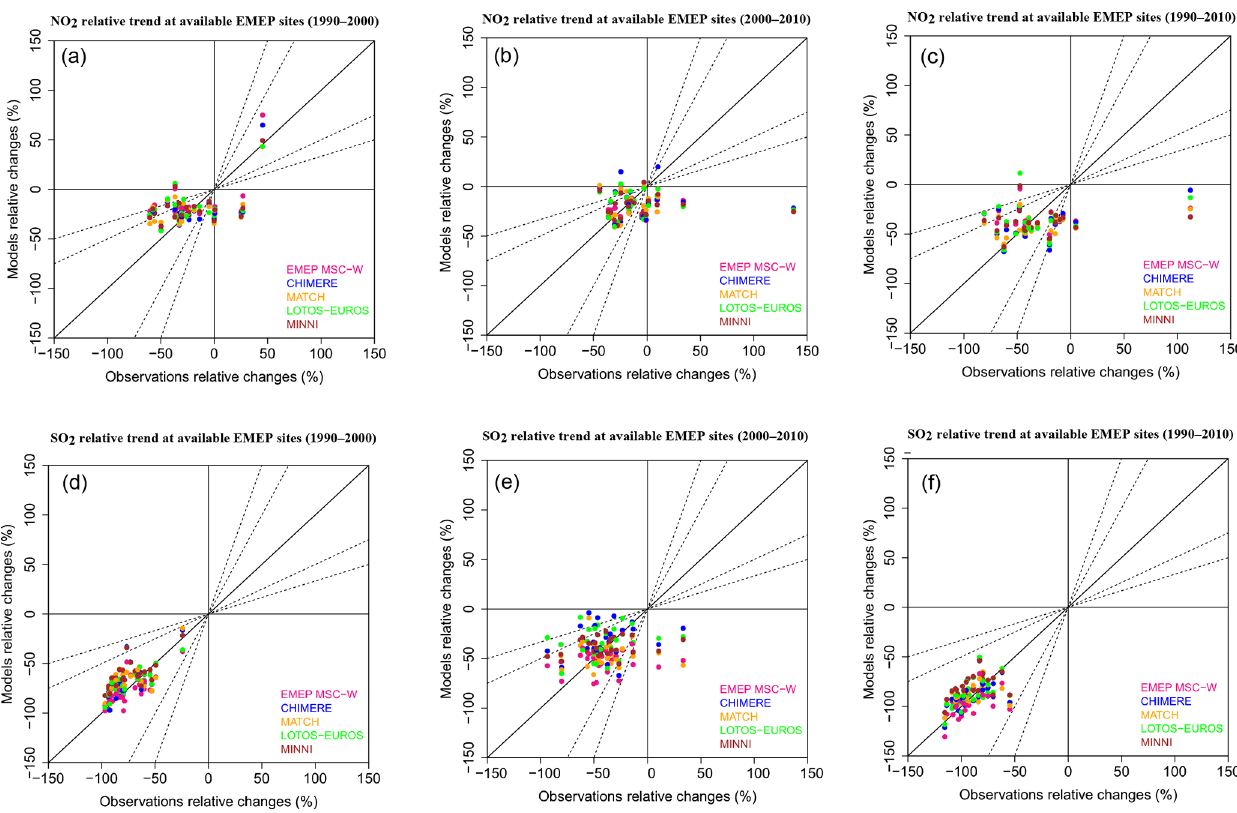
Figure 4. Modeled and observed NO 2 (a–c) and SO 2 (d–f) relative trends for the P1 (1990–2000), P2 (2000–2010) and PT (1990–2010) periods (left to right). The continuous line indicates the 1:1 line, and the dotted lines indicate the 1:2 and 1:3 lines (and their reciprocals).